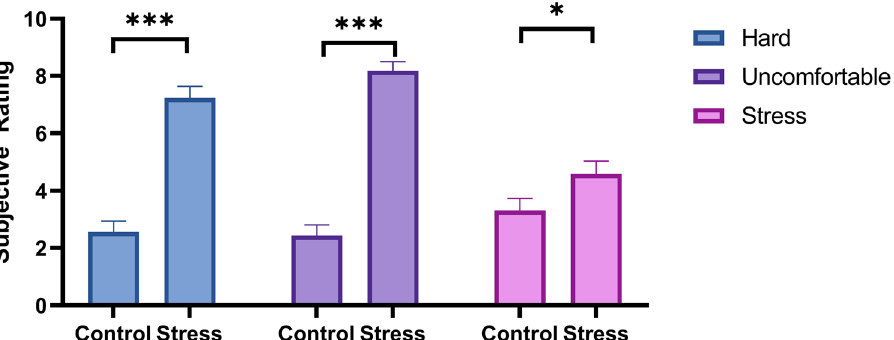
Figure 4. Comparison of subjective ratings following the CPT between conditions; error bars = standard error; *p < 0.05; *** p < 0.001; figure includes all participants (n control = 16, n stress = 17).